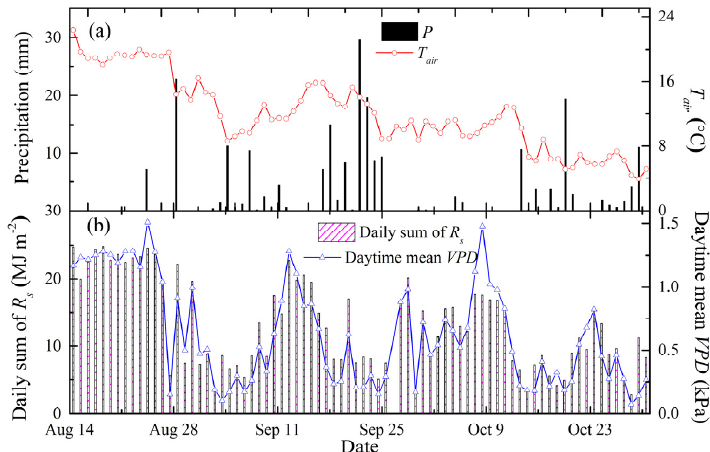
Figure 1. Daily values of ( a ) the precipitation and the air temperature ( T air ), and ( b ) the solar radiation ( R s ) and the daytime vapor pressure deficit ( VPD ) in the sap flow measurement period.